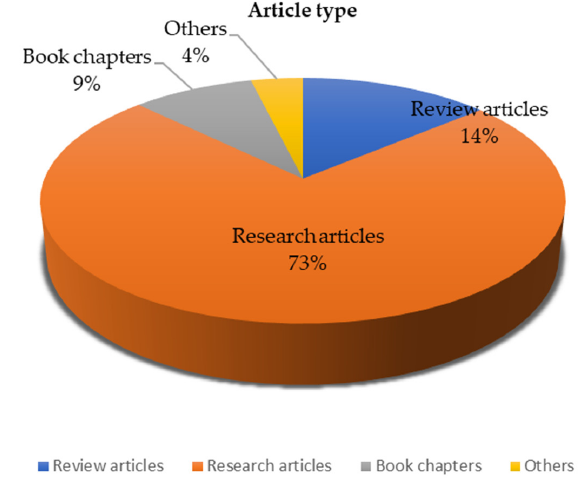
Figure 5. Percentage of FO publication per article type (1992–2020).